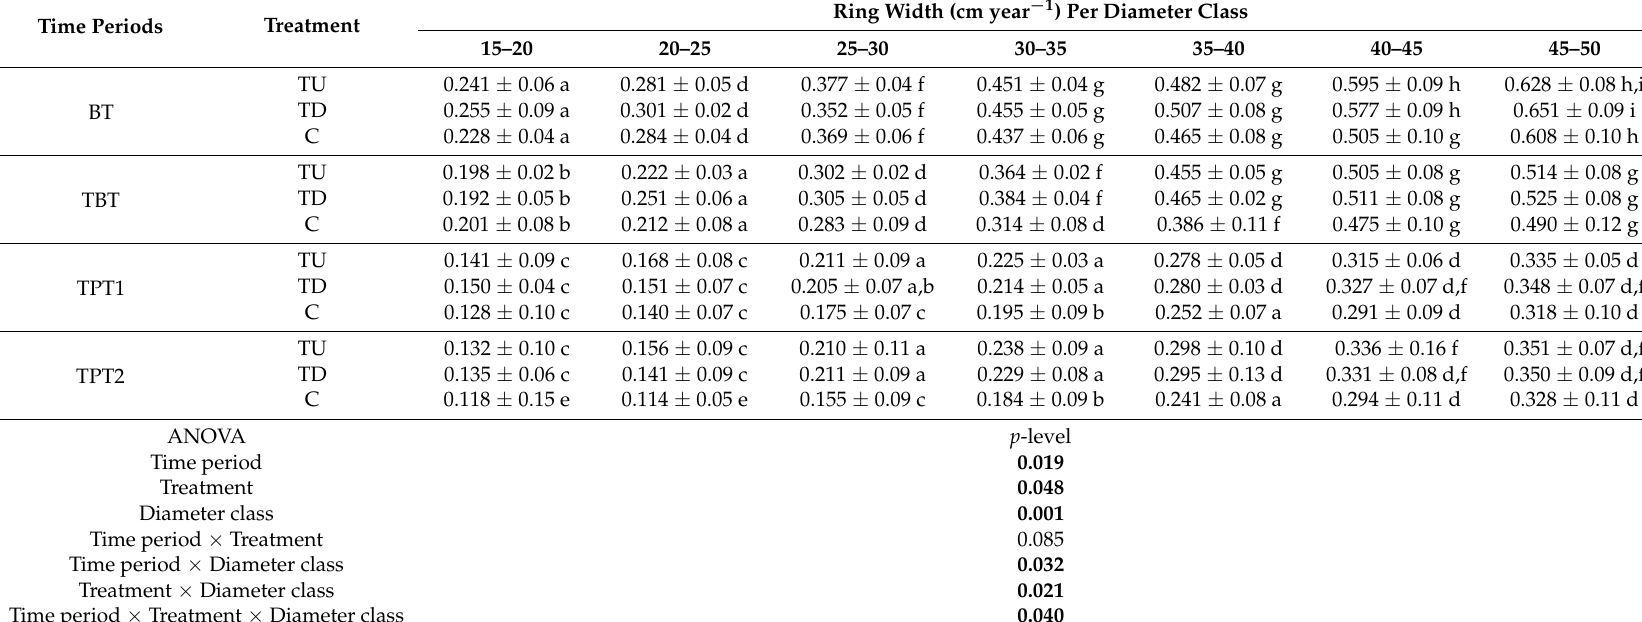
Table 7. Average ring width per diameter class in control area C (N. = 5 plots, 7 diameter classes, 2 stem core samples = 70) and damaged TD (N. = 25 plots, 7 diameter classes, 1 stem core samples = 175) and undamaged trees TU (N. = 25 plots, 7 diameter classes, 1 stem core samples = 175) in thinned area over different time periods (mean ±